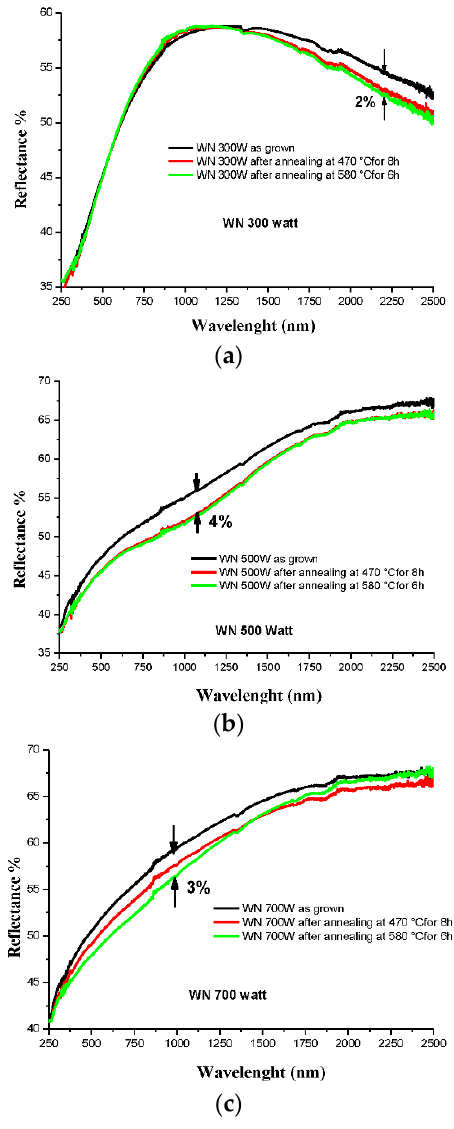
Figure 2. UV–VIS–NIR reflectance of ( a ) 300 W, ( b ) 500 W, ( c ) 700 W.